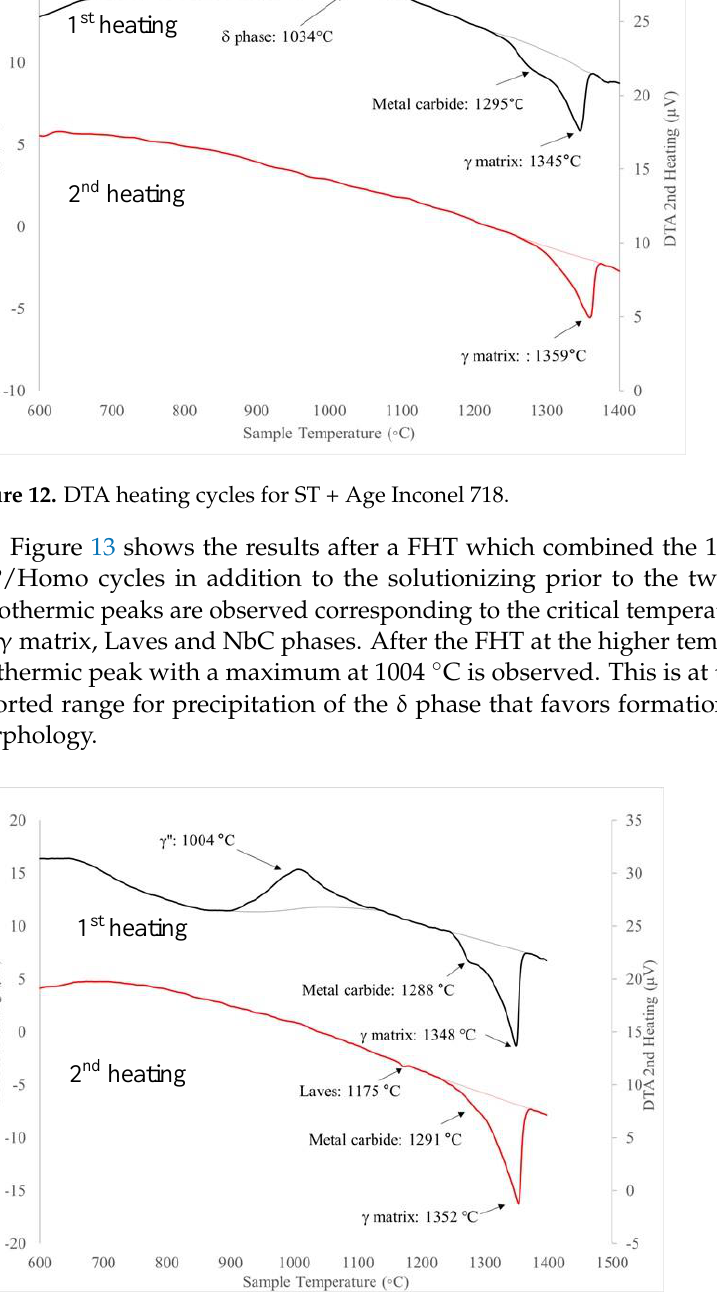
Figure 11. DTA heating cycles for DA Inconel 718.